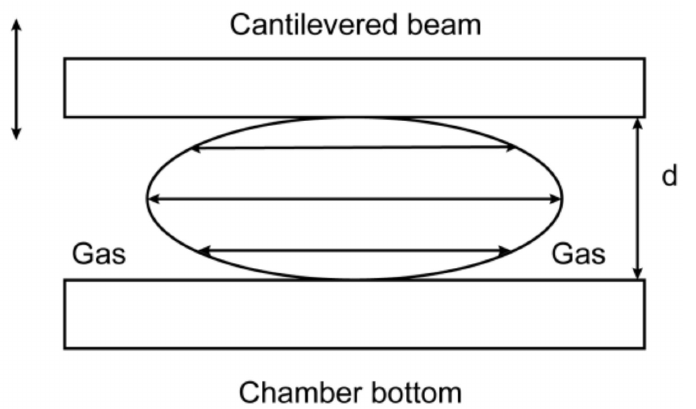
Figure 4. Squeeze-film damping model. The distance between cantilevered beam and chamber bottom is d. Table 2. Effective viscosity